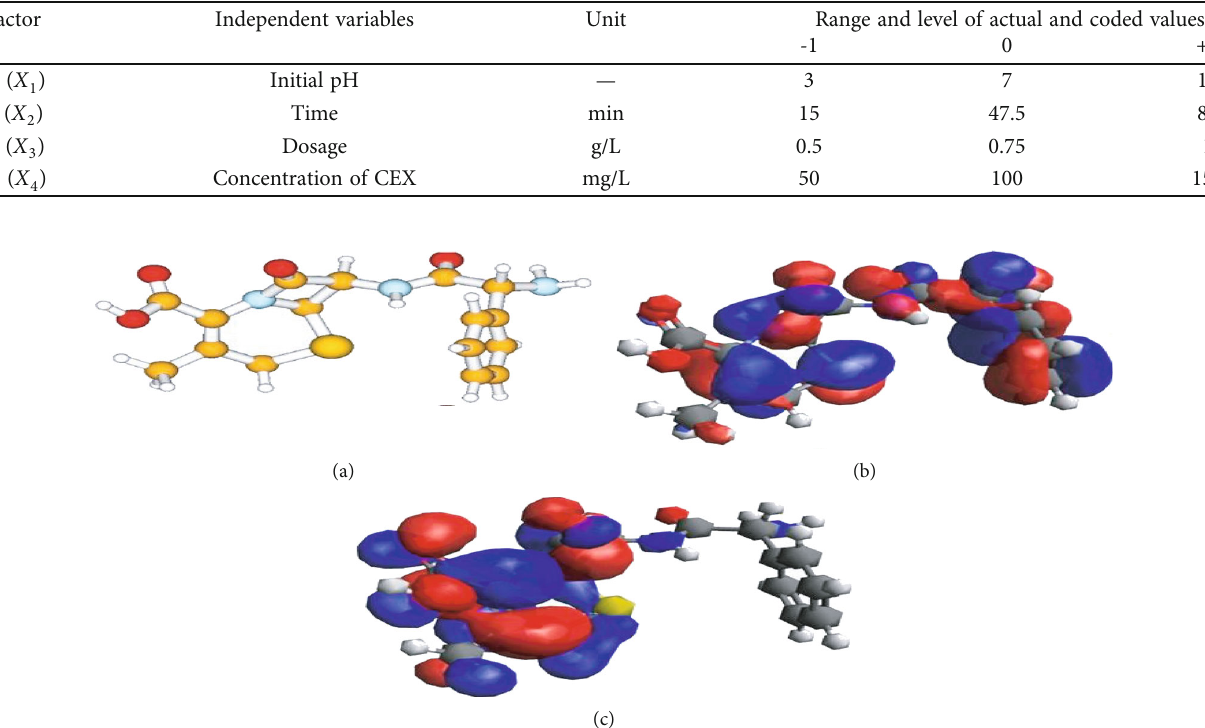
Table 2: Experimental levels tried for CEX onto Fe